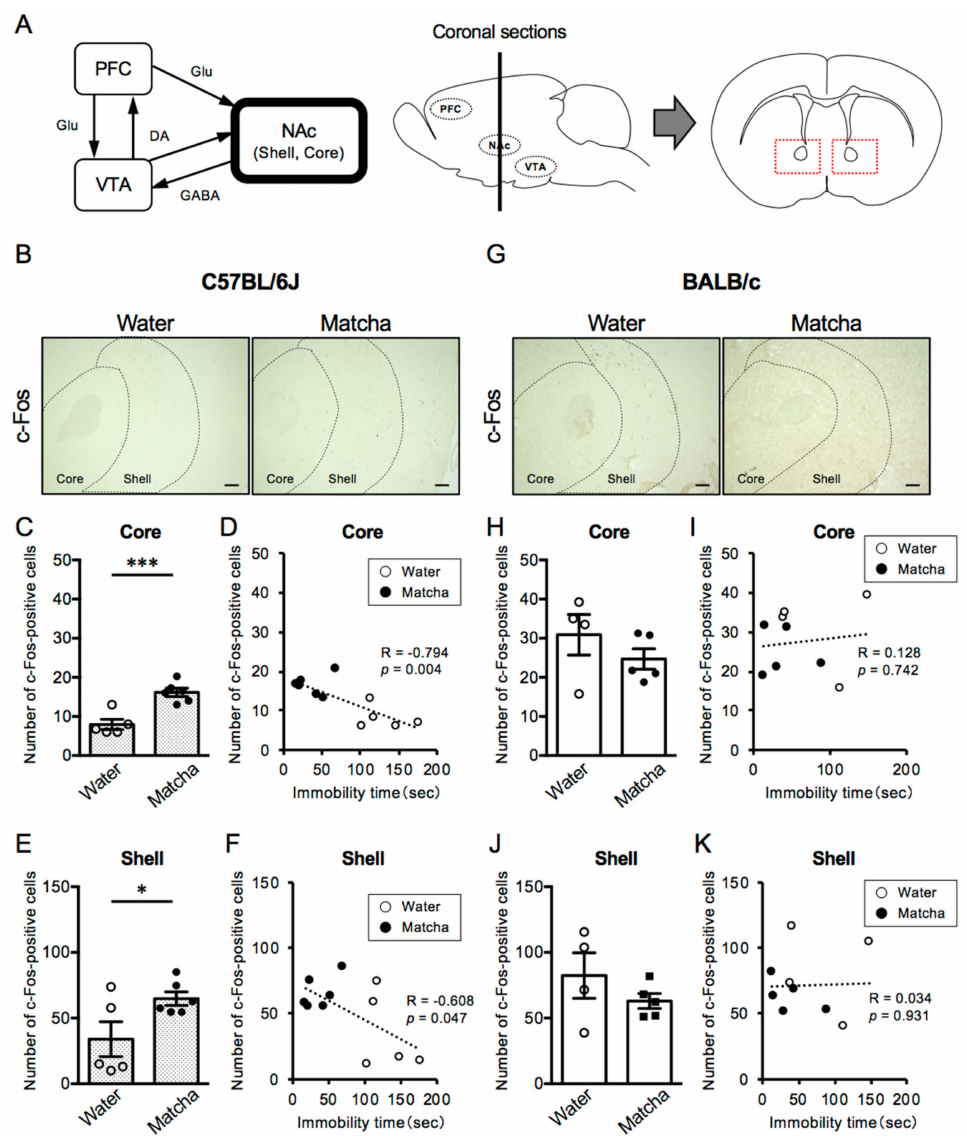
Figure 5. Effects of Matcha tea powder on the neural activity in the NAc region in C57BL/6J and BALB/c mice. ( A ) A schematic view of the PFC-NAc-VTA circuit (dopaminergic system). Dotted lines in red indicate the area of interest for image analysis of the number of c-Fos-positive cells in the NAc region. ( B , G ) Representative photographs showing immunohistochemistry on c-Fos in the NAc Core and Shell regions 2 h after Matcha tea powder administration (100 mg/kg, p.o.). ( C , E , H , J ) The quantification of the number of c-Fos-positive cells is shown. The results are expressed as the means ± SEM. n = 4–6 animals. The data were analyzed by the unpaired t -test. * p < 0.05, *** p < 0.001. ( D , F , I , K ) The correlation between immobility time in the TST and the number of c-Fos-positive cells in the NAc Core ( D , I ) and Shell ( F , K ) regions is shown. Scale bars = 100 µ m. DA; dopamine, GABA; γ -aminobutyric acid, Glu;